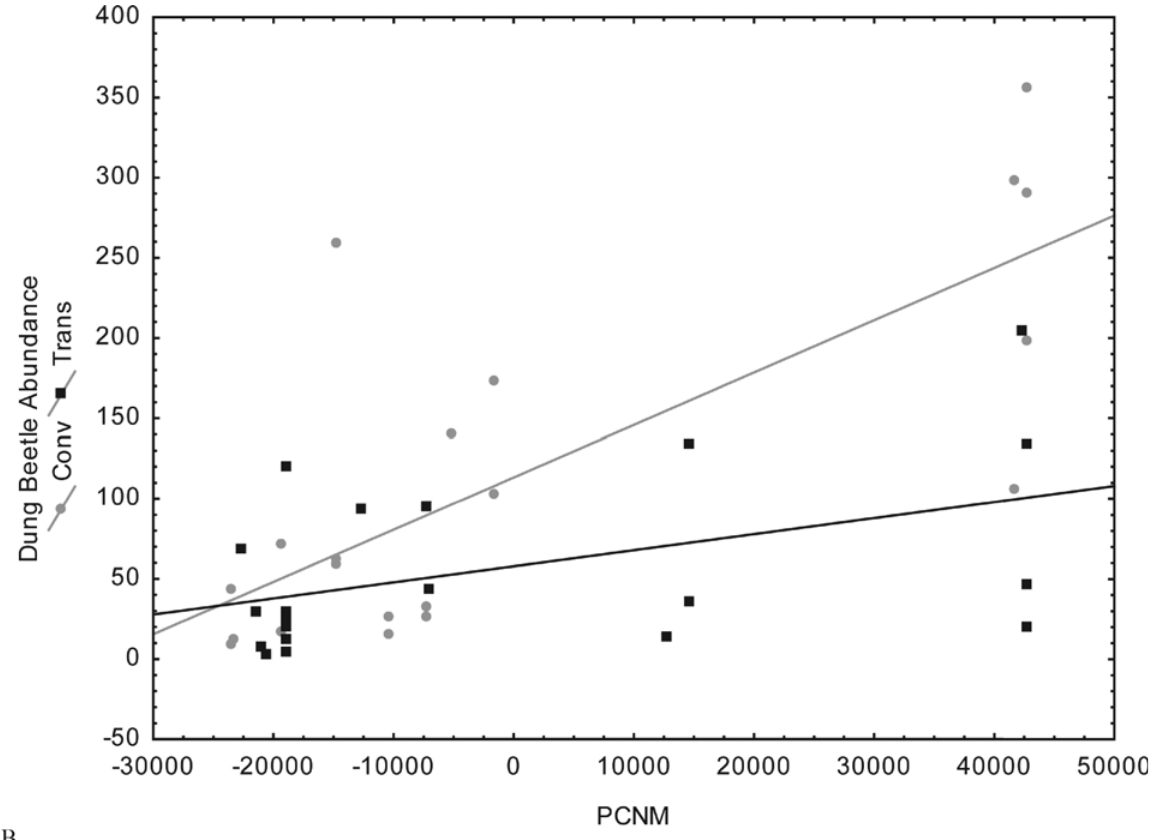
Fig 4. Distribution of dung beetle abundance in relation to spatial distance (PCNM) in 40 Atlantic Forest fragments adjacent to transgenic and conventional maize in Campos Novos, Southern Brazil.